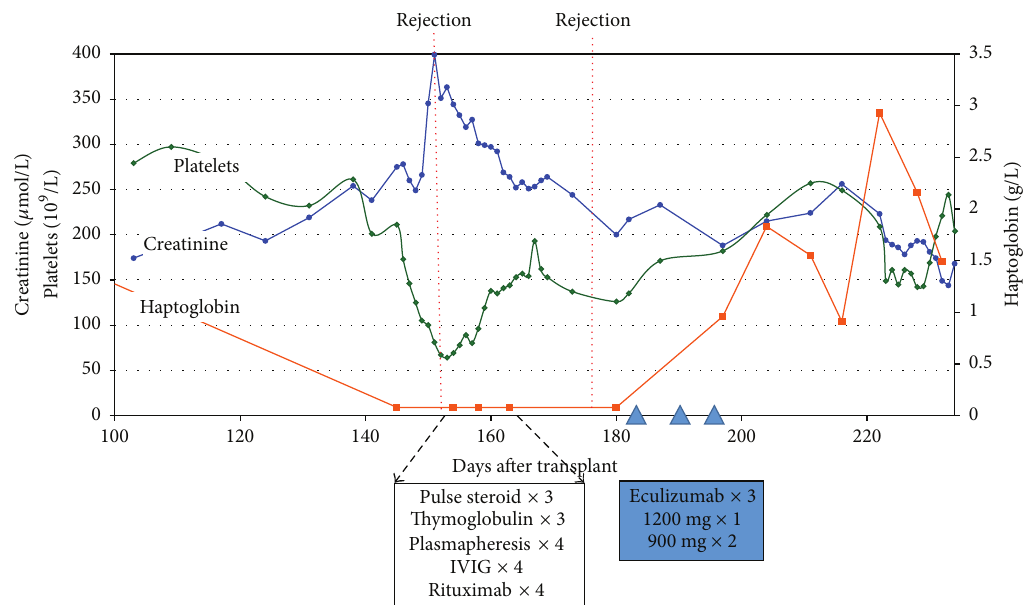
Figure 2: Graft function and microangiopathy markers.